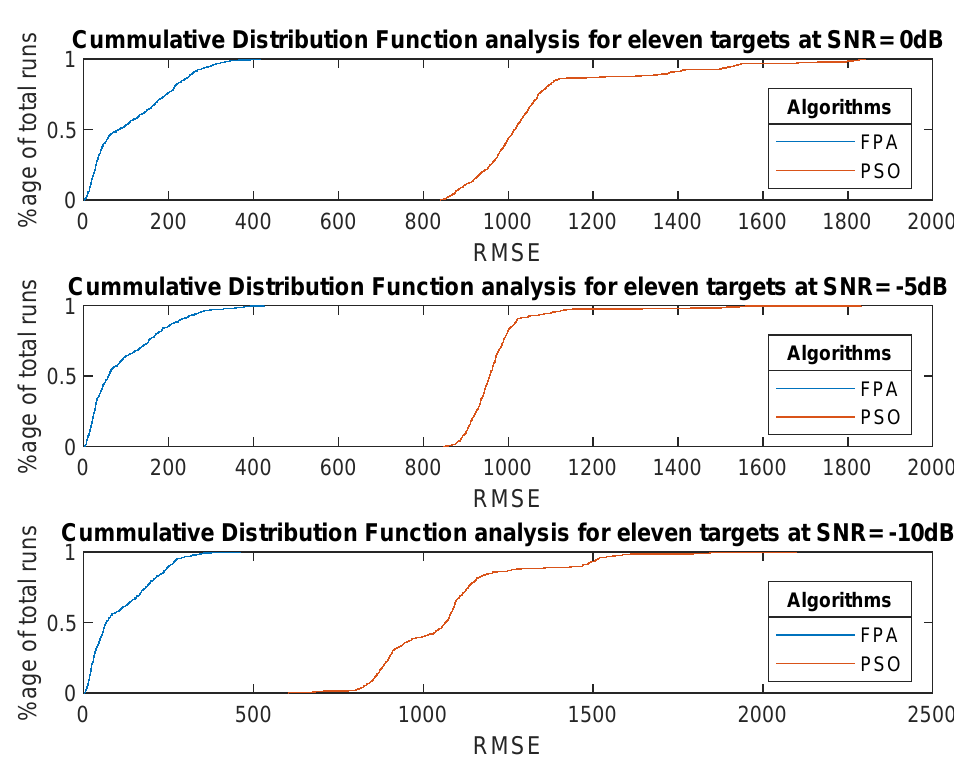
Figure 15. CDF analysis of RMSE for eleven targets at different